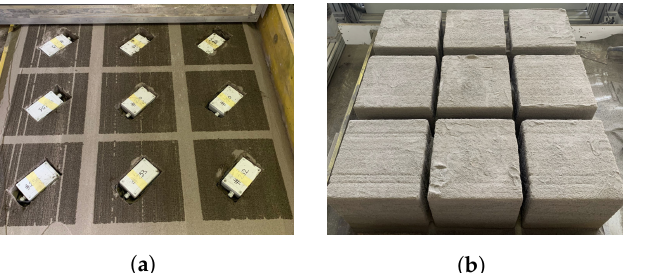
Figure 6. Two steps of the production phase with the embedding of Tinovi sensors. ( a ) Sensor embedding during production phase. ( b ) Final